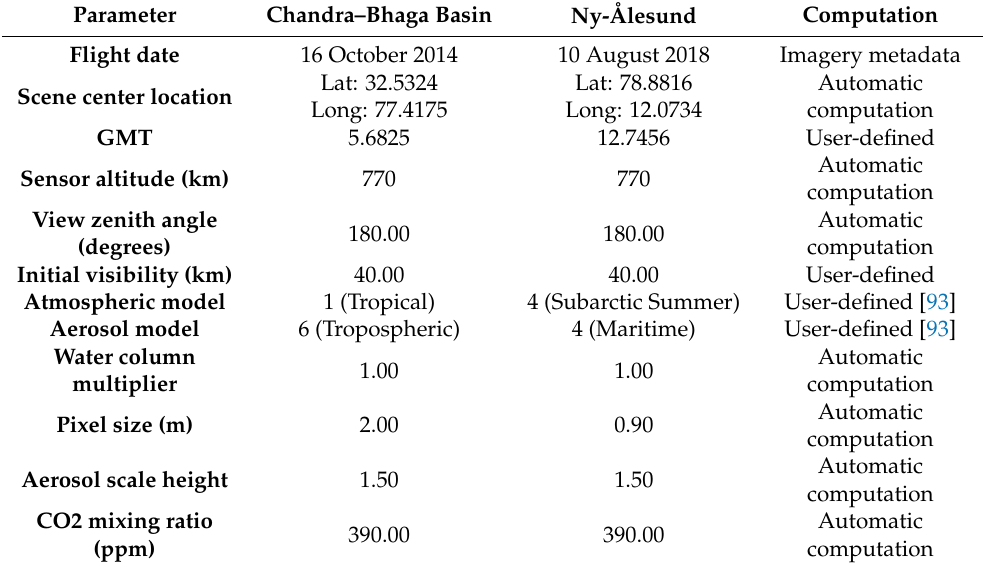
Table 3. Input parameters for FLAASH atmospheric correction.